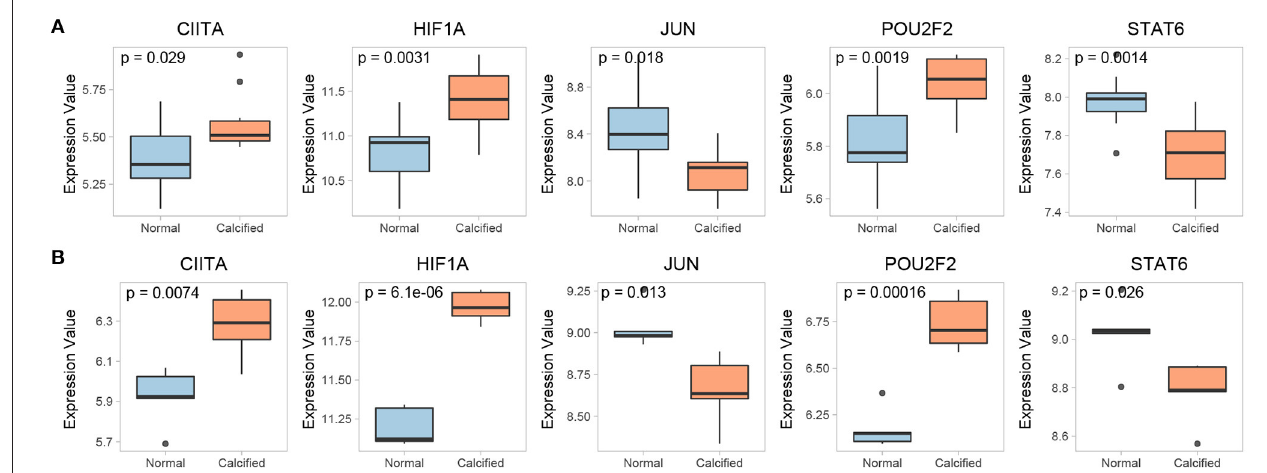
indicated that valve endothelial cells on both sides of the aortic valve leaflet showed differential side-specific gene expression, including that of Kruppel-like factor 2 (KLF2), which is an “atheroprotective” and “vasoprotective” TF. Additionally, previous studies noted that KLF2 can inhibit the expression of inflammation-related genes and regulate calcification caused by proinflammatory stimuli (61). Consistent with this, the